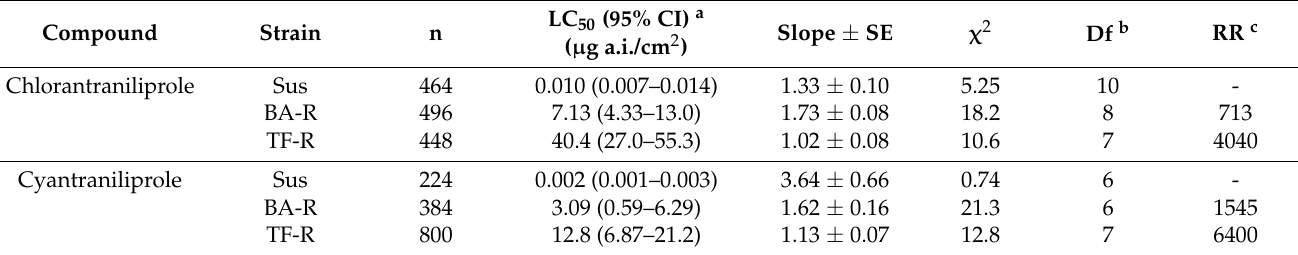
a Confidence interval, 95%; b degrees of freedom; c Resistance ratio (LC LC 50 of strain Sus).